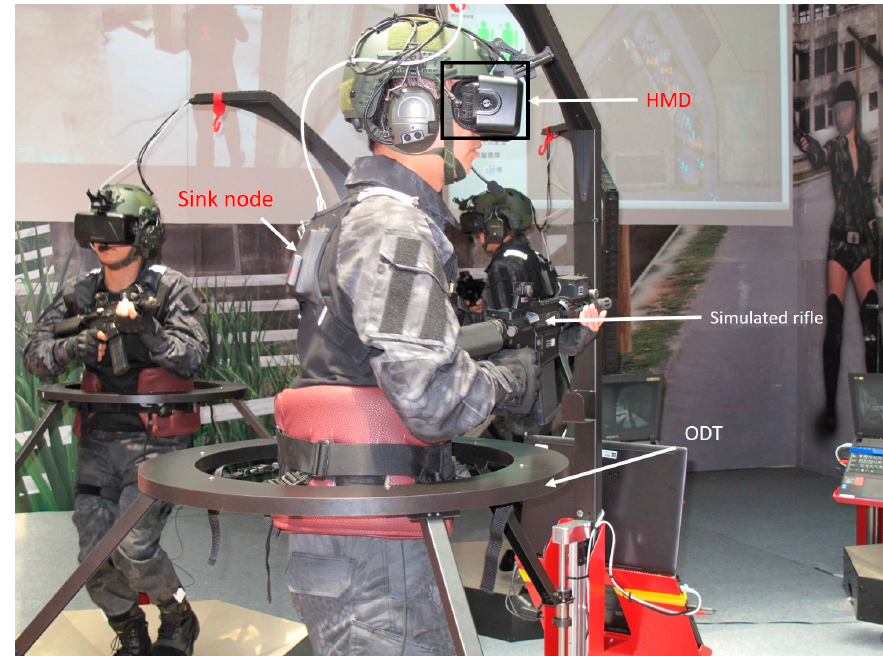
Figure 12. A fully equipped soldier.